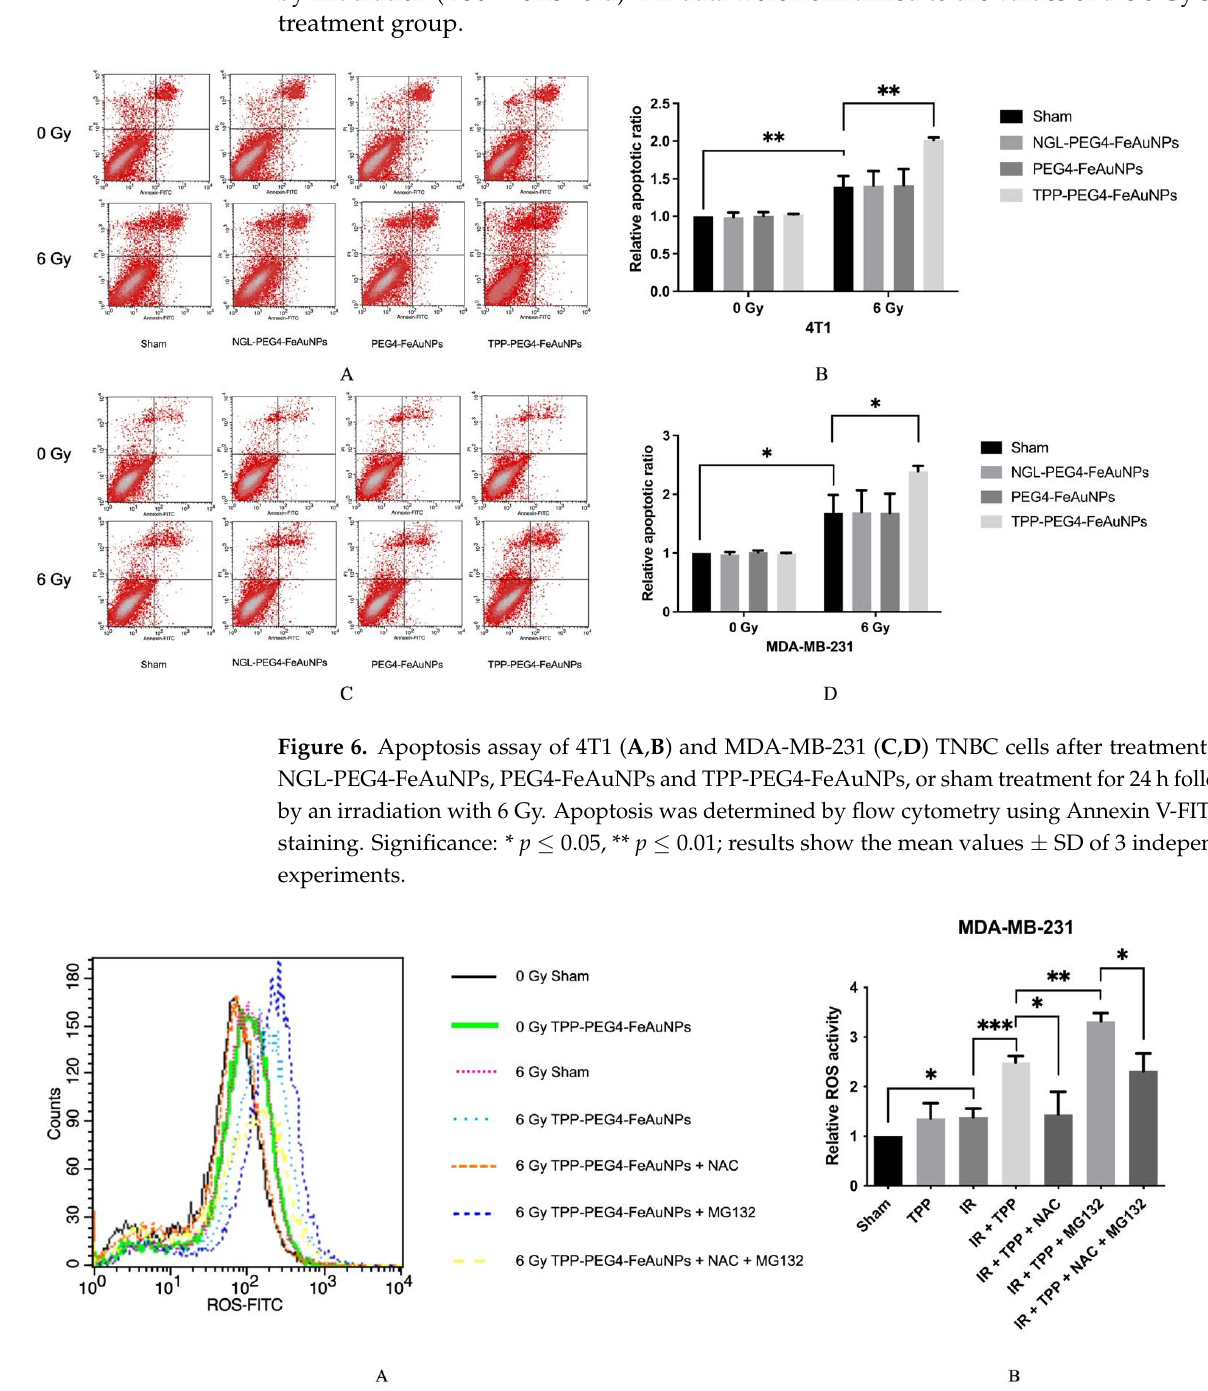
Figure 7. Analysis of the ROS production in MDA-MB-231 TNBC cells ( A , B ) after treatment with TPP-PEG4-FeAuNPs for 24 h, either alone or in combination with the ROS inhibitors NAC (5 mM) and MG132 (300 nM) and irradiation with 0 Gy and 6 Gy. ROS production was measured by DCFDA staining over 24 h by flow cytometry. Abbreviations: IR, irradiation; TPP, TPP-PEG4-FeAuNPs; NAC, N-Acetyl-L-cysteine; MG132, Z-Leu-Leu-Leu-al. Significance: * p ≤ 0.05, ** p ≤ 0.01, *** p ≤ 0.001. Results represent the mean values ± SD of 3 independent experiments.